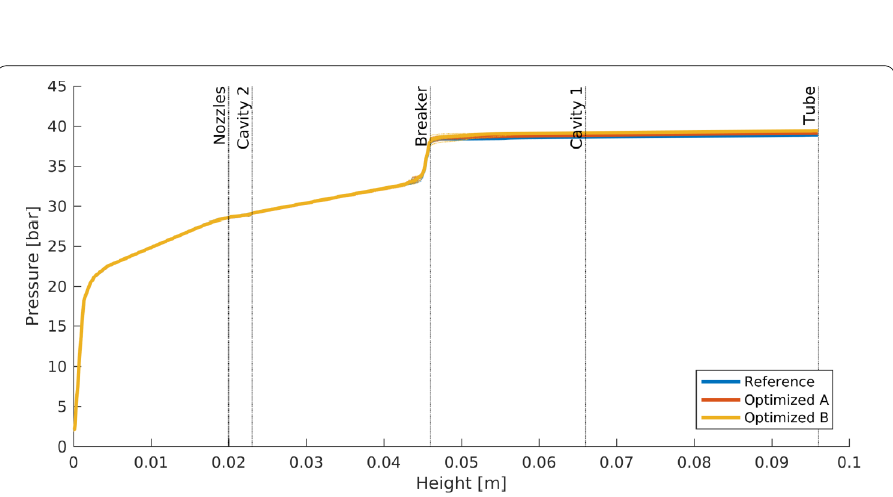
Figure 9 Pressure plotted vs. the height of the spin pack. There are only minimal differences in pressure between the three geometric